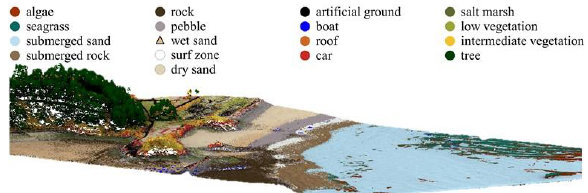
Figure 9. Extract of the resulting 3D classification: the land-water interface and its